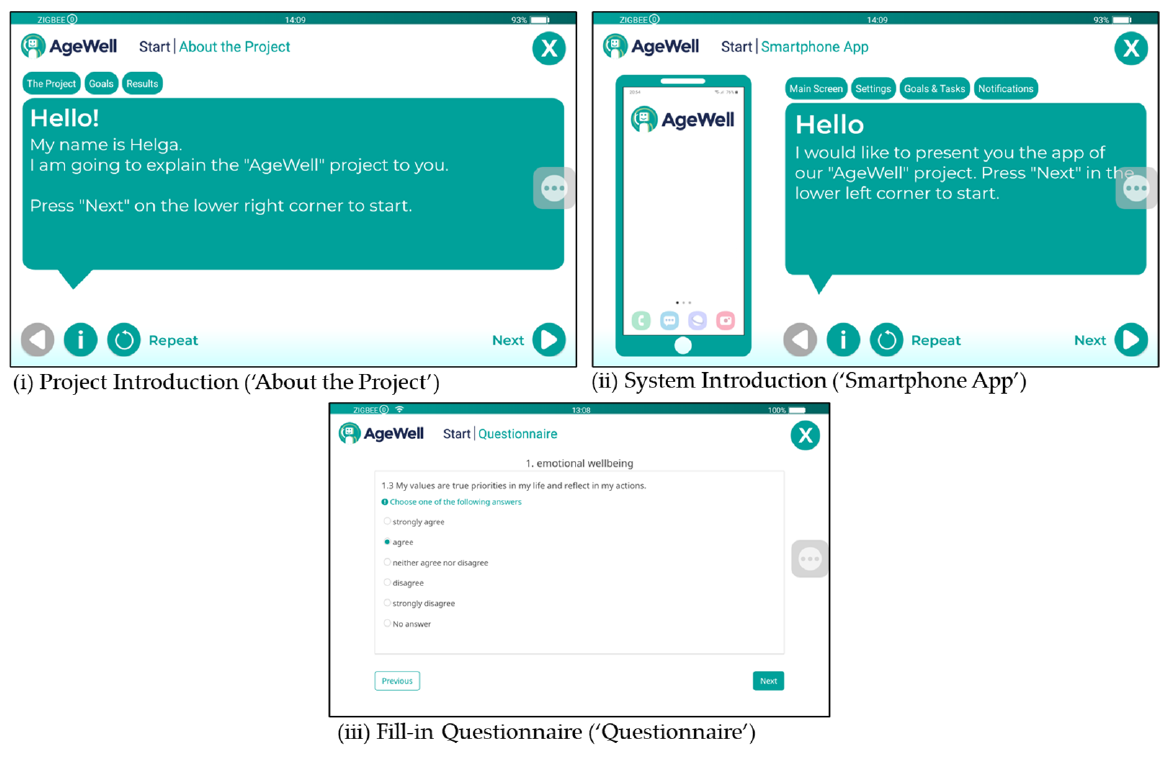
Figure 2. Interfaces for the three functions of the robo-coach.